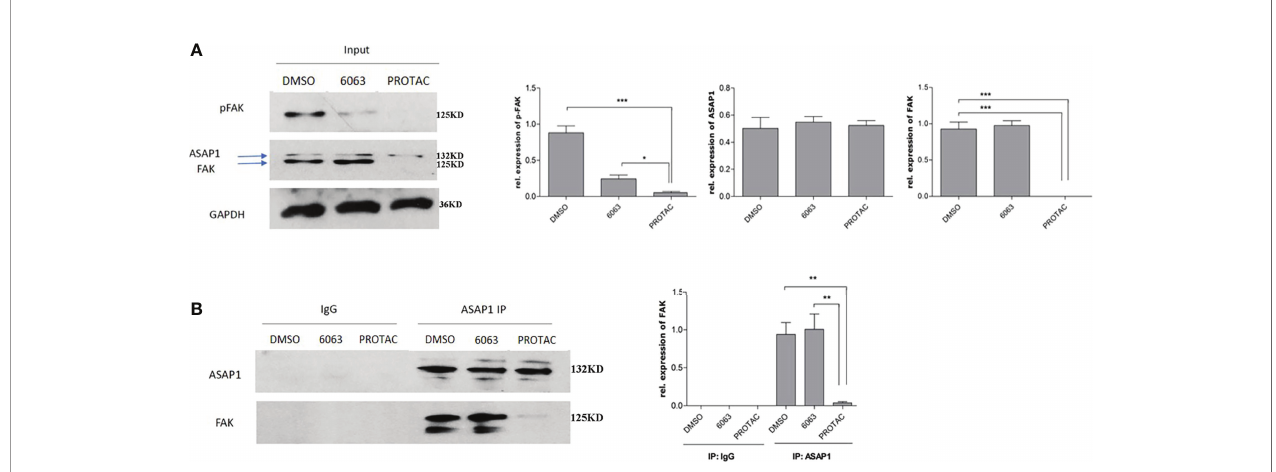
FIGURE 5 | FAK PROTAC disrupts the interaction between FAK and ASAP1 in OC cells. (A) OVCAR3 cells were treated with 1 µM FAK PROTAC and VS6063 for 24 h, WB of input shows changes in pFAK, FAK, and ASAP1 in each group. (B) Protein complex was pulled down with ASAP1 antibody and then blotted with both FAK and ASAP1 antibody. (* p <0.05; ** p <0.01; *** p <0.001).